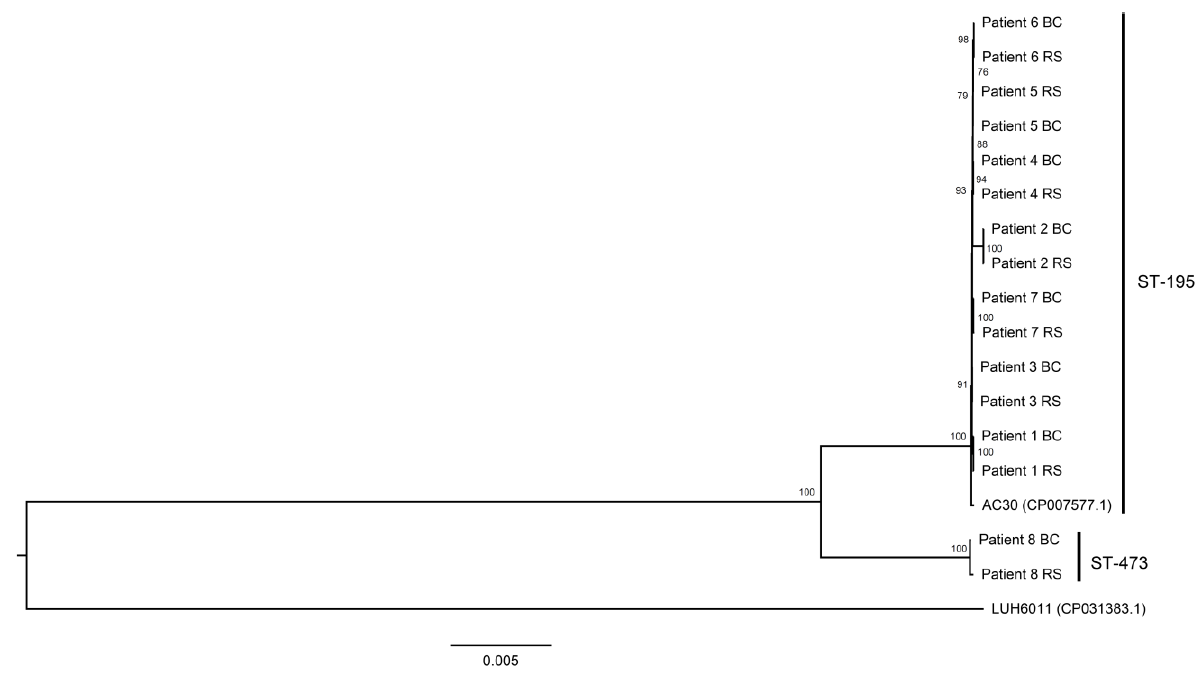
Figure 3. Maximum-likelihood phylogenetic tree of 16 CRAB isolates, which had resistance to all antimicrobial agents based on total core-genome single-nucleotide polymorphisms. These 16 CRAB isolates were also classified as MRAB and were collected from the blood culture (BC) and rectal swab (RS) from eight patients. Two MRAB control strains, LUH6011 (NCBI accession number CP031383.1) and AC30 (NCBI accession number: CP007577.1), were included as reference.